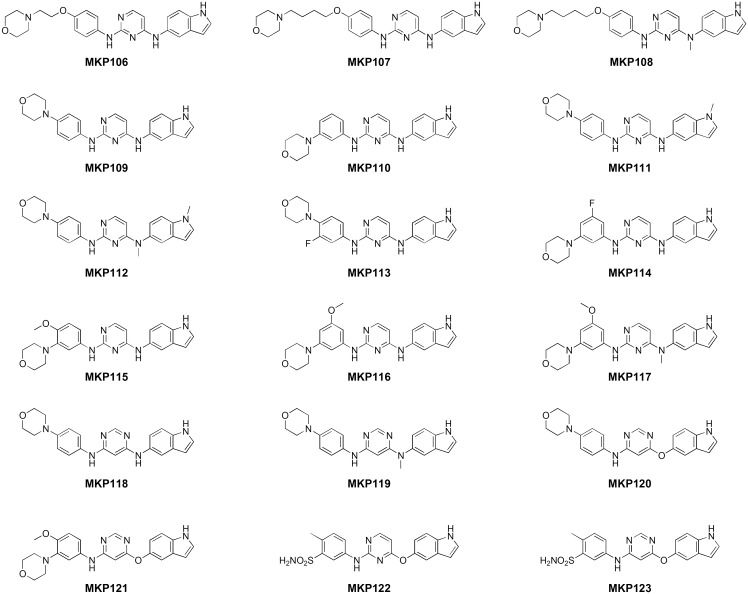
Structures of the indole tethered pyrimidine derivatives.